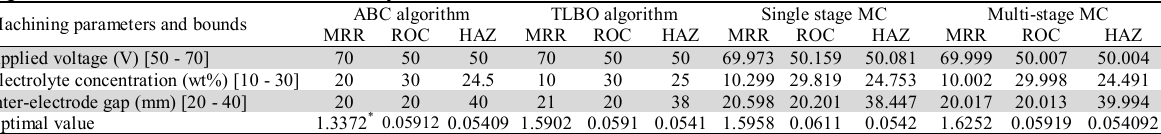
Optimization solutions of case study 4.2.1